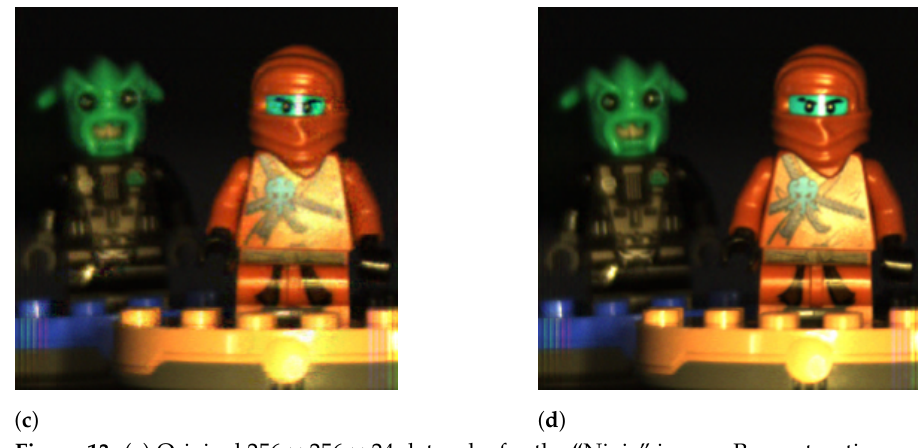
Figure 13. ( a ) Original 256 × 256 × 24 datacube for the “Ninja” image. Reconstructions using the LASSO algorithm, the DCT basis, and 4 × 4 blocks with: ( b ) 2 shots (PSNR = 19.42 dB), ( c ) 10 shots (PSNR = 30.47 dB), and ( d ) 20 shots (PSNR = 37.41 dB).